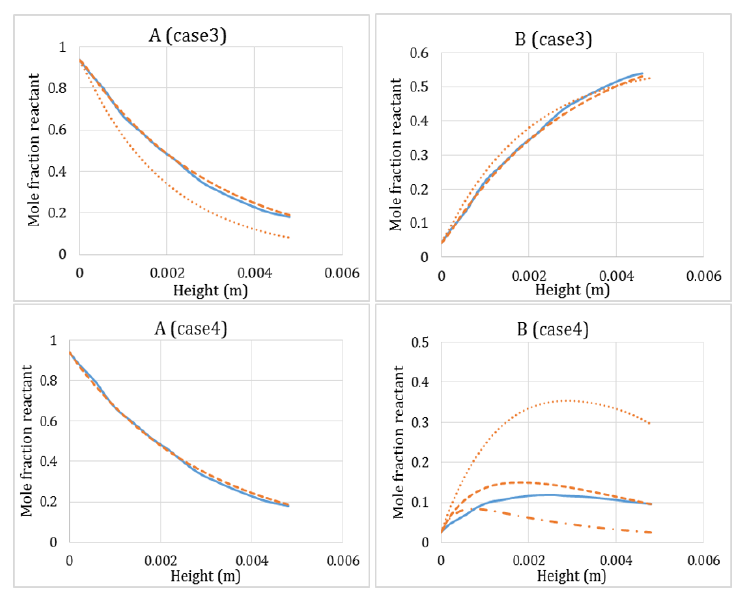
Figure 7. Comparison of the mole fraction of reactant (of specie A and specie B) for the simulated two cases, [Top] Case 3, and [Bottom] Case 4 from (i) PR-DNS (represented by solid lines); (ii) 1D model corrected (dashed lines); (dotted line) in Case 4 represents the prediction including a full mass transfer model for reactant B, while (interval line) represents a prediction without a mass transfer model; while in Case 3 (dotted line) represents the prediction with incorrect Thiele modulus.